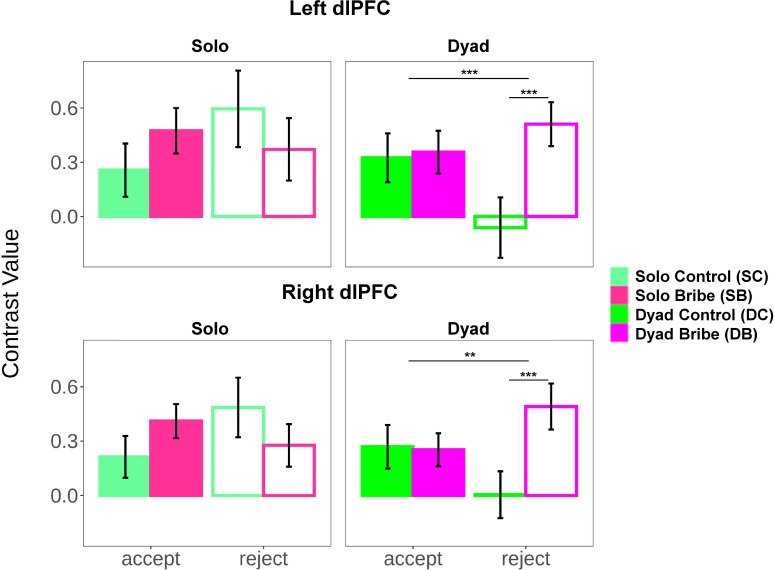
Modulation of scenario on the dorsolateral prefrontal cortex (dlPFC) activity during bribery-related decision-making regarding specific choice.For each participant, we extracted the contrast value within the activated clusters of dlPFC (see Figure 5A) in four experimental conditions in terms of two choices. Two-way repeated analysis of variance revealed a significant interaction between Choice (accept/reject) and Proposer’s Conduct (Bribe/Control) on dlPFC signal (i.e., contrast value) only in the Dyad scenario (left dlPFC: F(1, 32)=16.03, p<0.001; right dlPFC: F(1, 32)=12.95, p=0.001) but not in the Solo scenario (left dlPFC: F(1, 32)=2.92, p=0.097; right dlPFC: F(1, 32)=3.94, p=0.056). Post-hoc analyses showed that dlPFC activity was selectively enhanced when participants rejected an offer in the Bribe condition (Bribe vs. Control: left dlPFC: t(32) = 4.09, p<0.001; right dlPFC: t(32) = −3.64, p<0.001), but not when accepting an offer (left dlPFC: t(32) = 0.30, p=0.769; right dlPFC: t(32) = −0.22, p=0.826), which drove the interaction. Error bars represent SEM. Significance: **p < 0.01, ***p < 0.001.